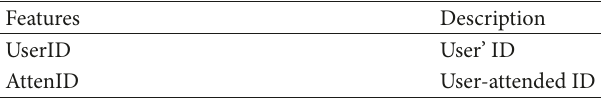
Table 4: Data structure and description of the user attention. Features